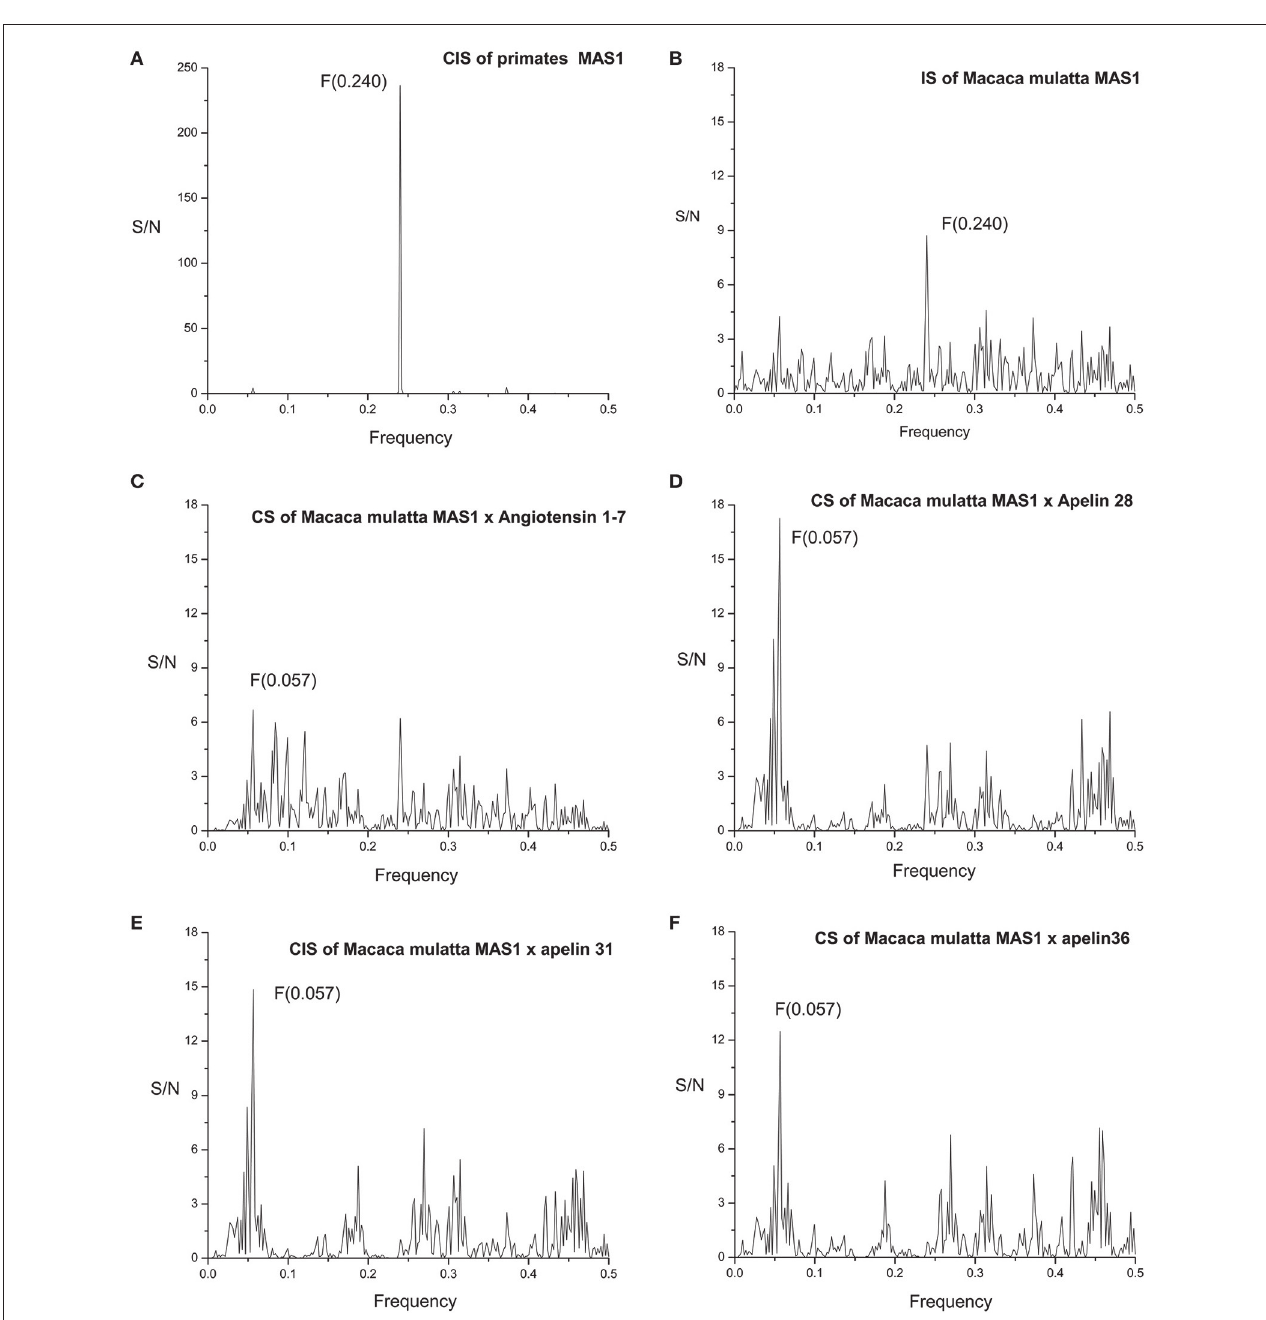
FIGURE 3 | (A) Consensus informational spectrum (CIS) of primates MAS1; (B) Informational spectrum (IS) of MAS1 of Macaca mulatta; (C) CS of Macaca mulatta MAS1 and angiotensin 1-7 and (D) CS of Macaca mulatta MAS1 and apelin 28, (E) CS of Macaca mulatta MAS1 and apelin 31 (F) CS of Macaca mulatta MAS1 and apelin